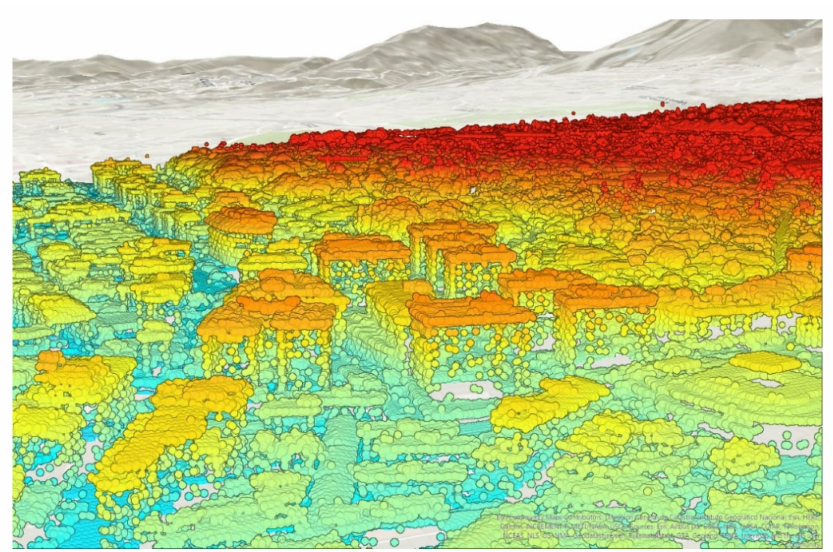
Figure 3. *LAS cloud of